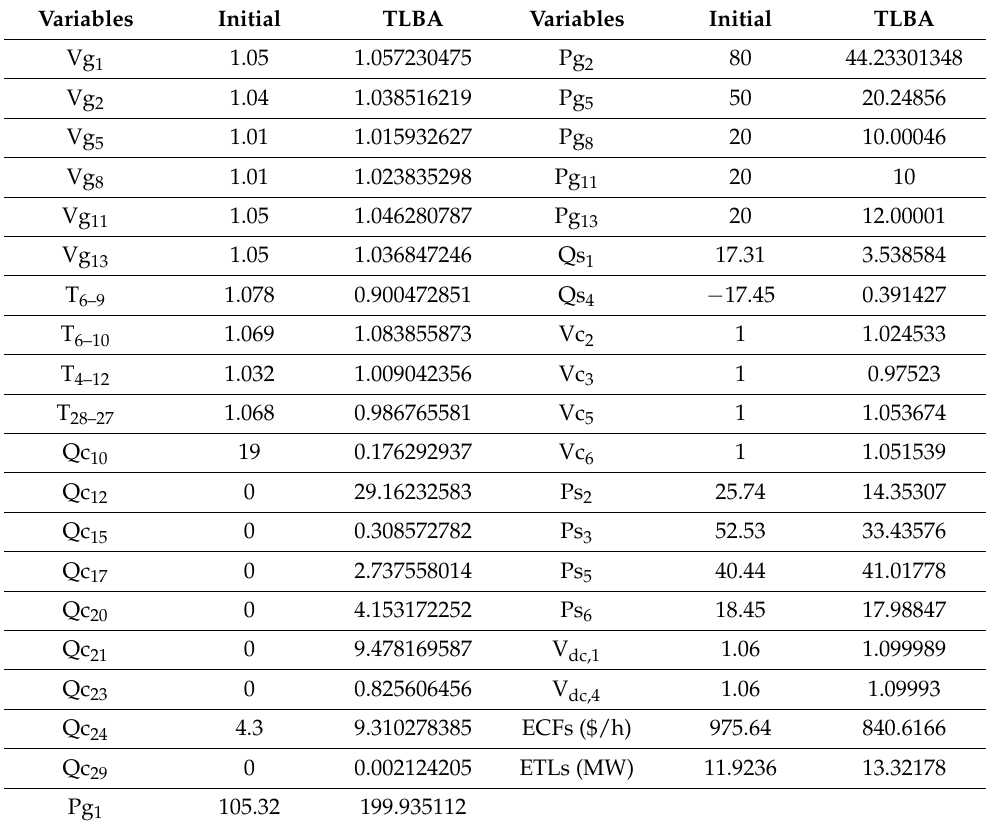
Table 1. Simulation results of TLBA for the minimization of the TFCs of the IEEE 30-bus network. Variables Initial TLBA